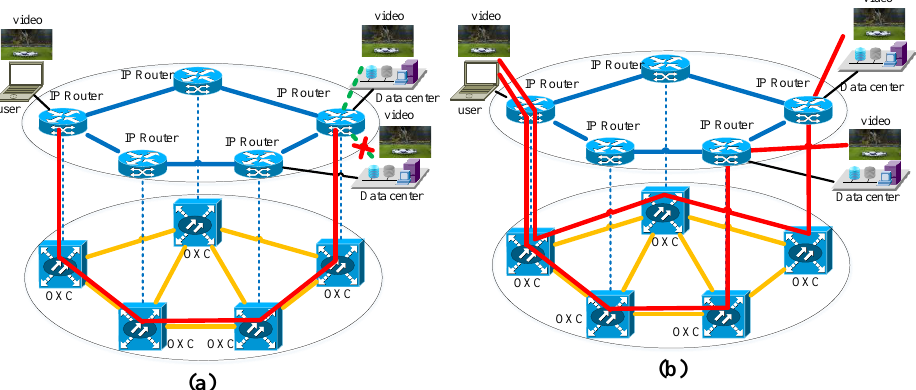
Figure 7. Network and content connectivity: ( a ) video service provisioning through one end-to-end light path; ( b ) video service provisioning through end-to-content light paths; OXC: optical cross connect equipment.